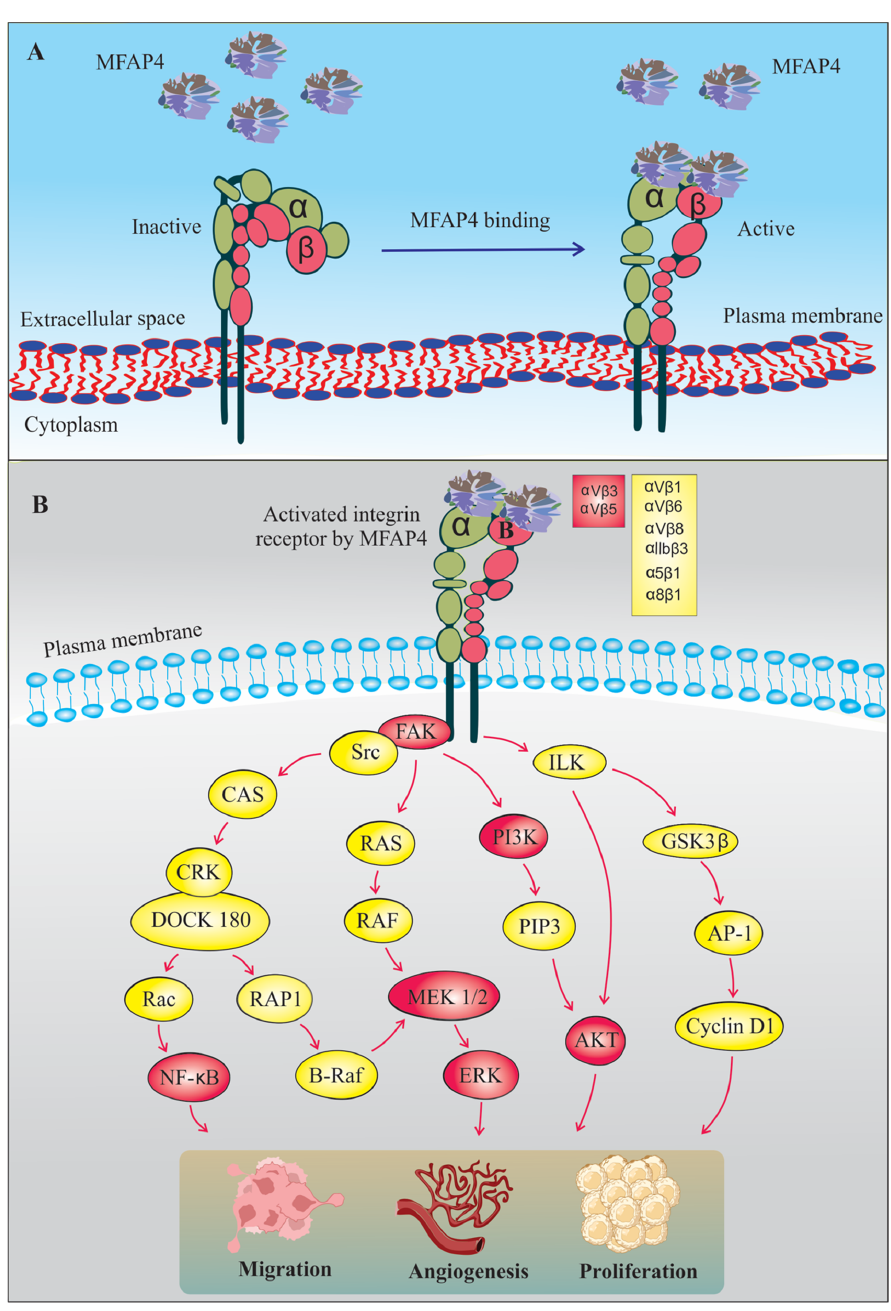
Figure 3. Integrin-dependent signaling secondary to MFAP4 recognition. ( A ) Suggested conformational changes of integrin heterodimer after MFAP4 binding. ( B ) MFAP4-dependent integrin ligation initiates downstream intracellular signaling pathways leading to cellular activation